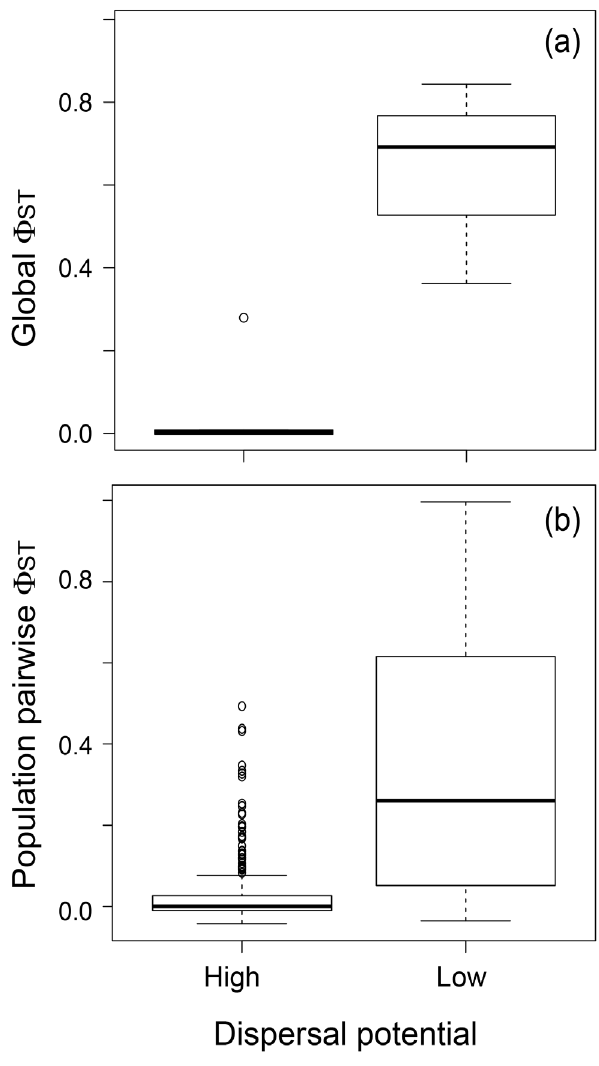
Figure 3. Box-plots of global (a) and average population- pairwise (b) W ST for high and low dispersers.